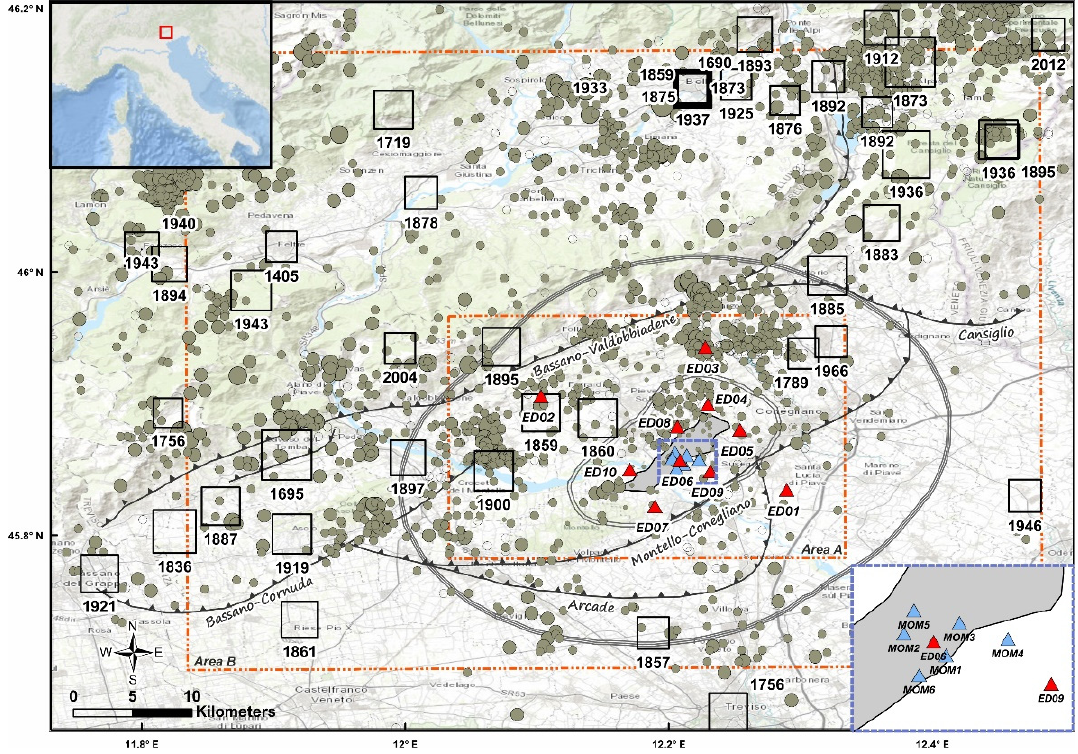
Figure 1. Epicentral location map of seismicity recorded by RSC (red triangles) in the period 01/01/2012-29/03/2021 (http://rete-collalto.crs.inogs.it/DATI/Localizzazioni/H71/fri/eventi-sismici- full-period.txt, accessed on 20 March 2022). The magnitude of earthquakes (green circles) ranges between − 0.9 to 3.8. The Collalto array is reported with blue triangles. The Collalto underground gas storage is shown in grey with the internal (two grey lines) and extended domain (three grey lines) areas. The monitoring areas A and B according to [6] are highlighted with dashed red lines. Historical seismicity with epicentral macroseismic intensity I0 > 4 is reported (CPT15, [34]). Thrust faults of the compressive external front of the eastern Southern Alps are displayed according to [30].